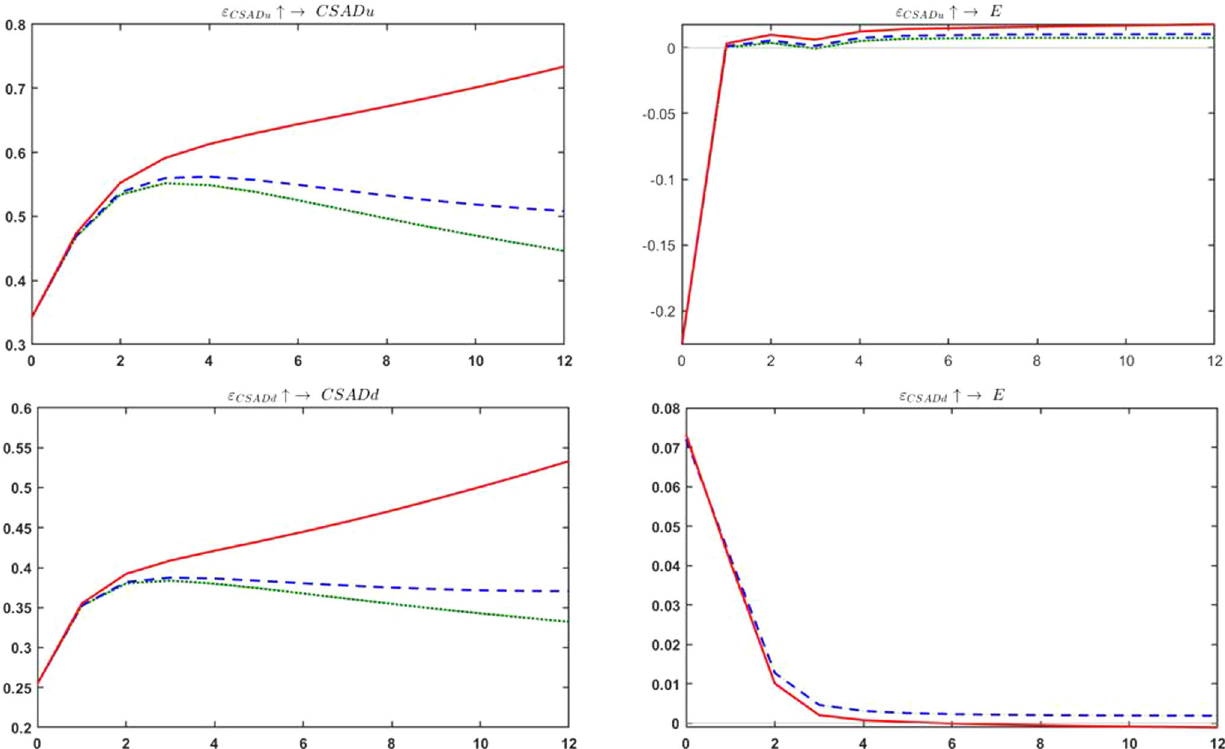
Fig. 6 Impulse responses at different time points. The responses of market dispersion and internet postings to a unit shock in increasing dispersion or decreasing dispersion at different time